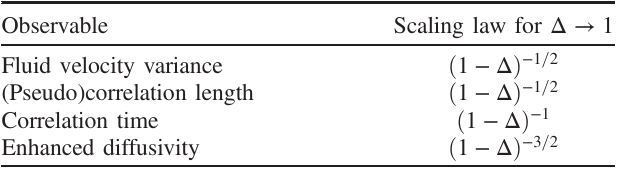
TABLE I. Critical